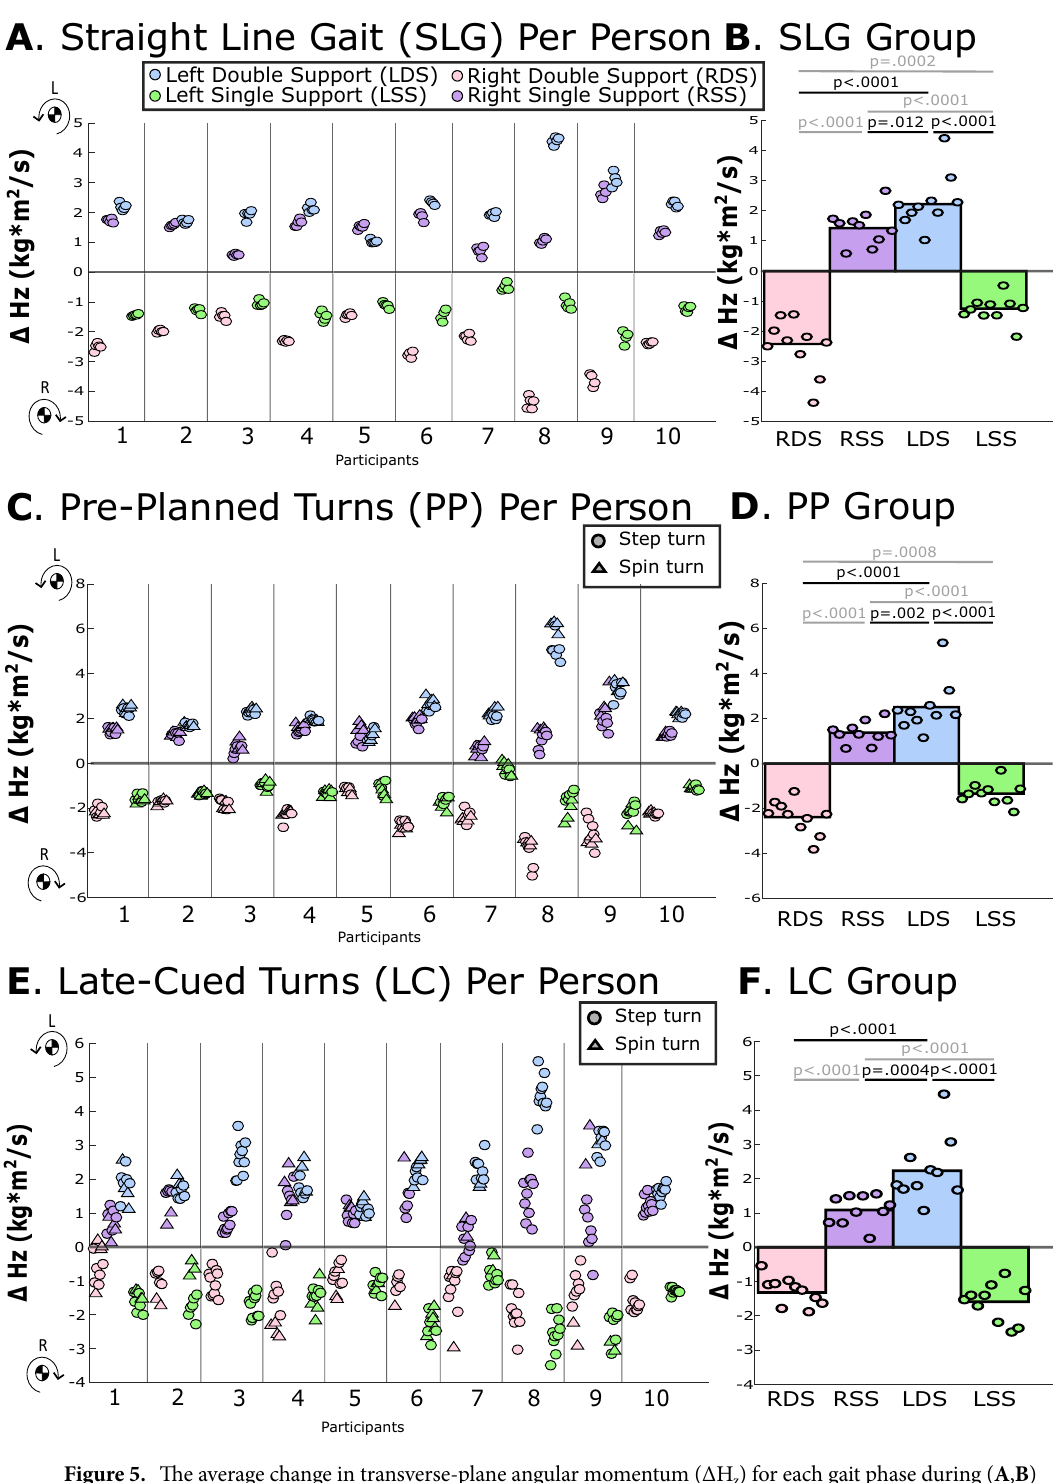
Figure 5. The average change in transverse-plane angular momentum (∆H z ) for each gait phase during ( A , B ) straight-line gait, ( C , D ) pre-planned turns, and ( E , F ) late-cued turns. Positive H z is leftward in the direction of the turn. The left panel ( A , C , E ) provides average ∆H z for each gait phase, each trial, and each participant, with step turns indicated with circles and spin turns indicated with triangles. In the right panel ( B , D , F ), each circle indicates the average value for each participant across multiple trials and the bar represents the across- participant (group) averages. Horizontal lines with p-values indicate statistically significant differences between gait phases at the group level, those in gray are significant differences that were not related to the